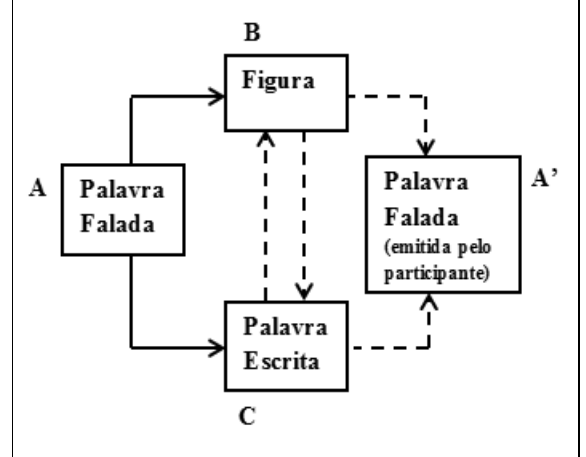
Figura 1 . Rede de relações ensinadas e testadas no procedi- mento de escolha de acordo com o modelo. As setas contínuas representam as relações ensinadas e as pontilhadas representam as relações